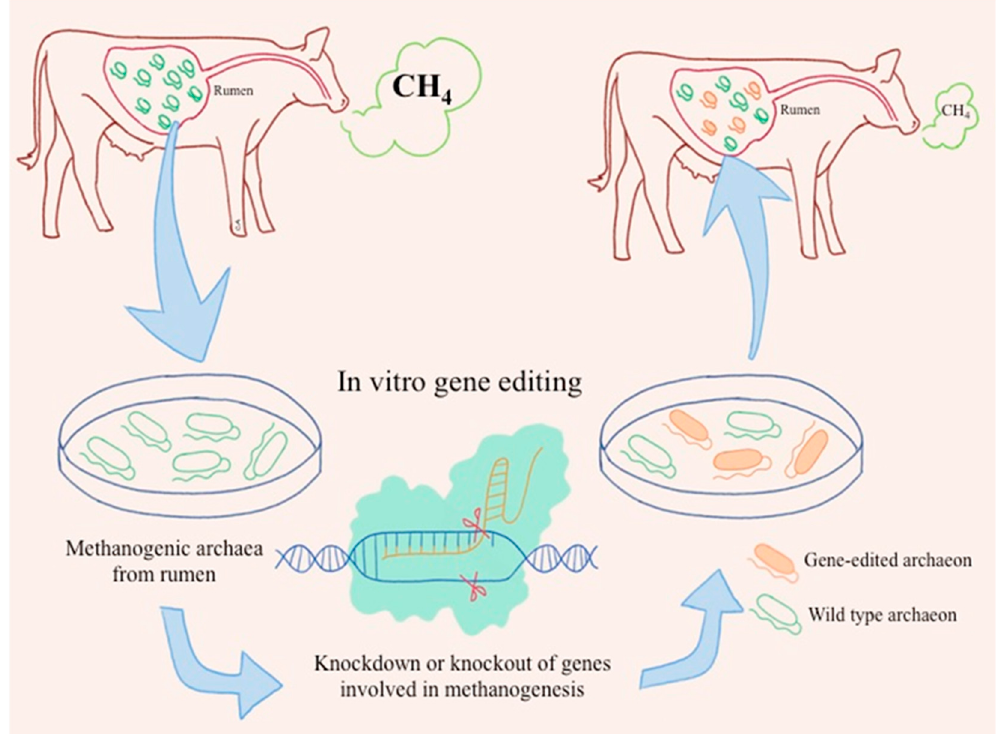
Figure 3 . Possible in vitro approach for the gene editing of rumen archaea. Methanogenic archaea would be collected from the rumen and cultured in vitro, at which point genes involved in methanogenesis could be knocked down or knocked out using genome editing technologies such as CRISPR/Cas9. The gene-edited archaea would then be replicated in vitro and reintroduced into the rumen for repopulation. As long as the edited archaea were competitive within the rumen population, the expected result would be a reduction in the production of CH 4 from the ruminant.